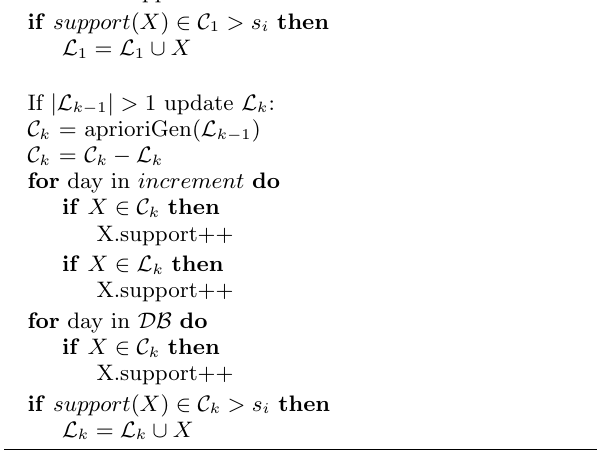
Algorithm 4 Sequence Apriori